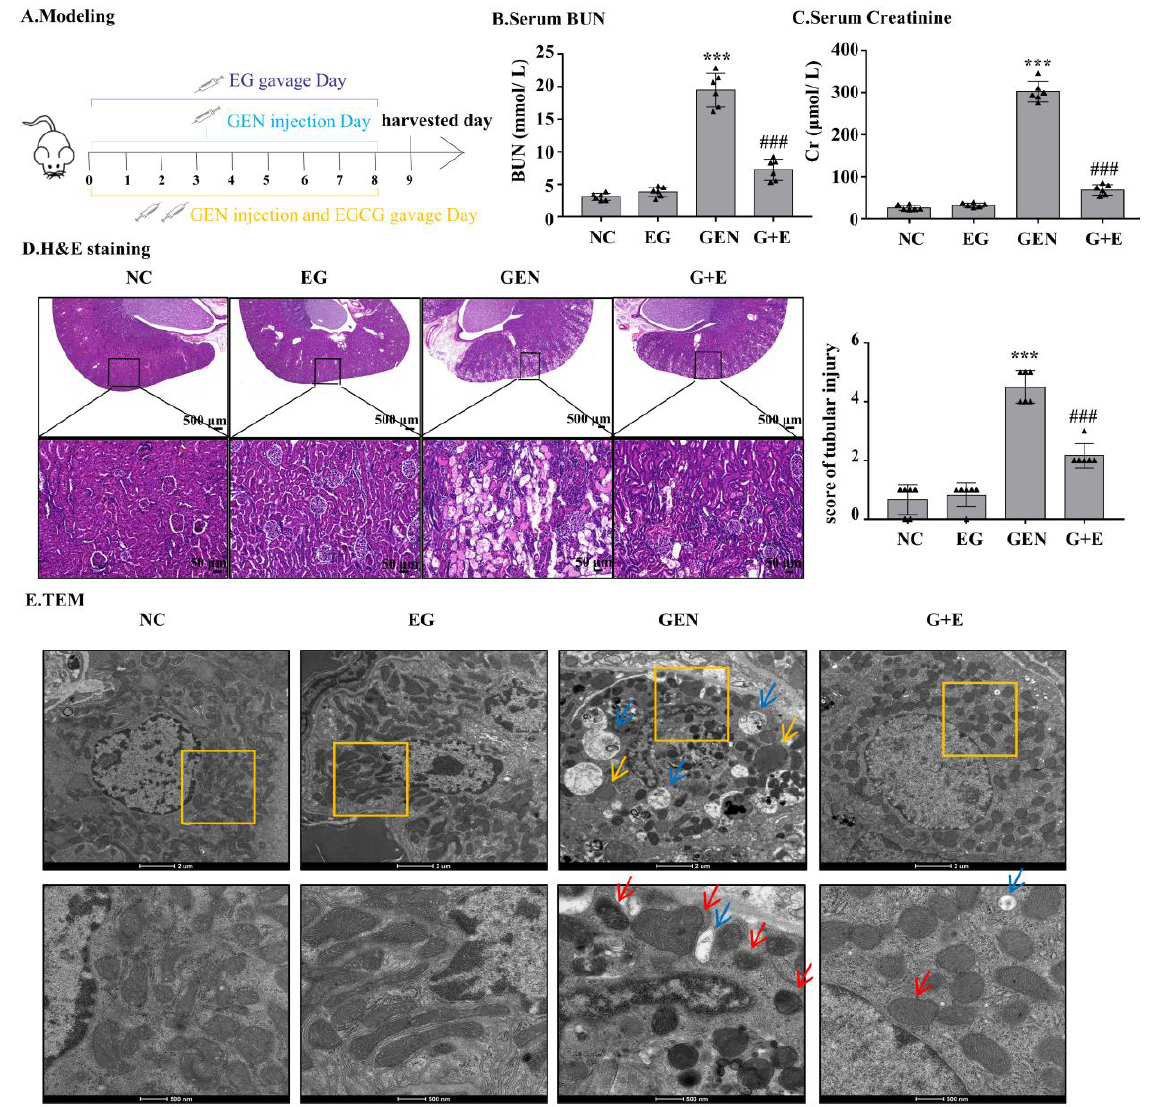
Figure 1. Epigallocatechin gallate (EG) reduced gentamicin (GEN)-induced nephrotoxicity in Sprague–Dawley (SD) rats. ( A ) The therapy design in different groups. SD rats were given either 100 mg/kg GEN by intraperitoneal injection or 100 mg/kg EG by oral administration daily. ( B ) Serum BUN. ( C ) Serum creatinine. ( D ) Representative HE staining images of the rat kidney sections were observed under a bright field microscope. Scale bars = 500 μm and 50 μm. In vivo data was expressed as mean ± SEM of six rats. ( E ) The ultrastructural changes of kidney were observed by transmission electron microscopy. The red arrow indicated mitochondrial cristae disappearance and outer membrane rupture. The yellow arrows indicated the increased peroxisome and the blue arrows indicated the increased autophagic vacuoles. Scale bars = 2 µ m and 500 nm. *** p < 0.001 vs. the normal group; ### p < 0.001 vs. GEN group.